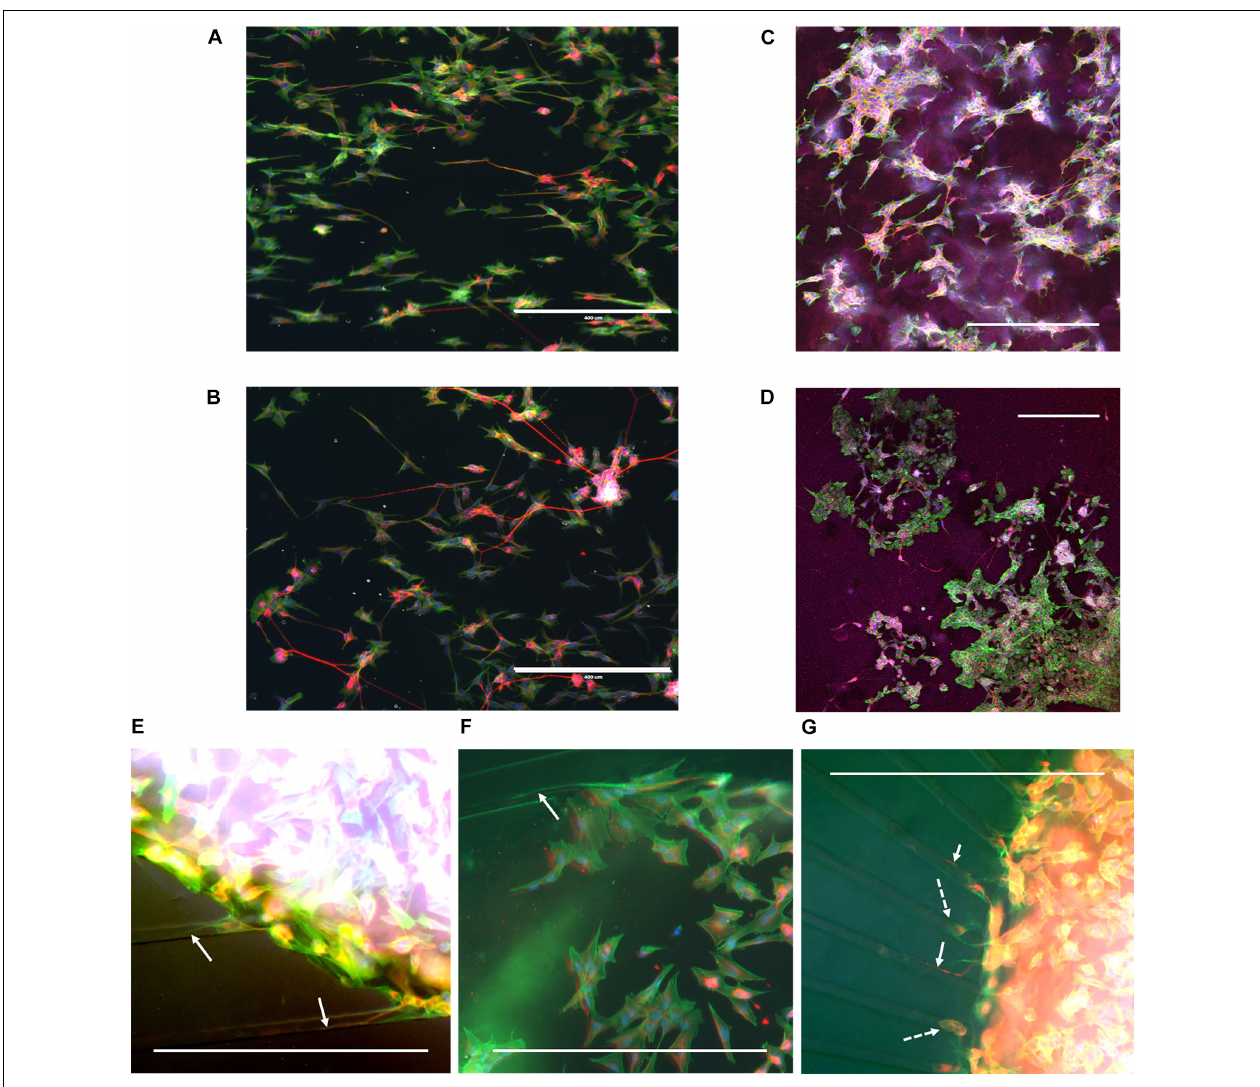
FIGURE 4 | Example overview of SH-SY5Y cells in a range of different 2D and 3D microenvironments. SH-SY5Y cells were cultured for 21 days in vitro (DIV) in a series of different microenvironment containing either flat or nanogrooved substrates and consisted of either a 2D cell culture or a 3D cell culture in a hydrogel microenvironment on top of a substrate. Cells were differentiated into the neuronal phenotype on 0–3 DIV using retinoic acid and at 4 DIV with brain-derived neurotrophic factor. Cells were cultured on a nanogrooved substrate in 2D (A) , on a flat substrate in 2D (B) , on a nanogrooved substrate with a 3D hydrogel microenvironment (C) , on a flat substrate with a 3D hydrogel microenvironment (D) , in a microtunnel device with a nanogrooved substrate (E) , a microtunnel device with a flat substrate (F) , and a microtunnel device with a radial configuration and a flat substrate (G) . Immunofluorescence staining shows neuron-specific staining β -Tubulin III in red, F-actin in green and cell nuclei in blue. Scale bars denote 400 µ m. White arrows highlight neurites that have grown into microtunnels, white dashed arrows show cell bodies present in microtunnels. Image contrast and brightness was increased for (E–G) to increase visibility of neurites within the